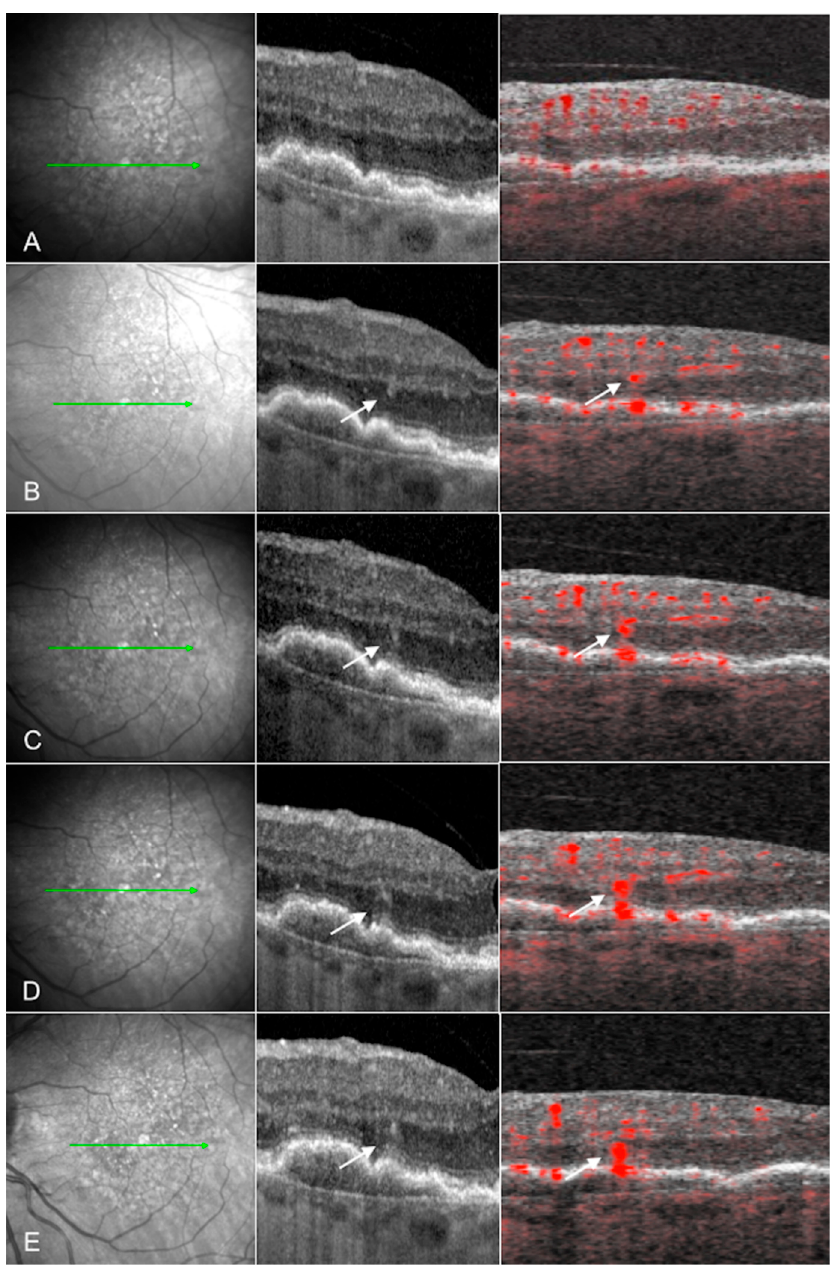
Figure 2. Courtesy of Sacconi et al. 2019: Evolution of type 3 macular neovascularization : Near infrared (NIR) reflectance (left column), structural optical coherence tomography (OCT) B-scan (middle column), and cross-sectional OCT angiography (OCTA) (right column) images of one eye with a type 3 macular neovascularization (MNV) from a patient with age-related macular degeneration (AMD) at ( A ) the first preclinical stage examination and after ( B ) 5 months, ( C ) 8 months, ( D ) 12 months, and ( E ) 15 months. The MNV originates from the deep retinal capillary plexus, evident as a small intraretinal hyperreflective focus on OCT and a punctate flow signal on cross sectional OCTA (white arrows). The lesion progresses downward toward the RPE over time (from ( A ) to ( E )). These lesions may be driven by choriocapillaris ischemia, as eyes with type 3 MNV have significantly increased choriocapillaris flow deficits with OCTA [95,96].